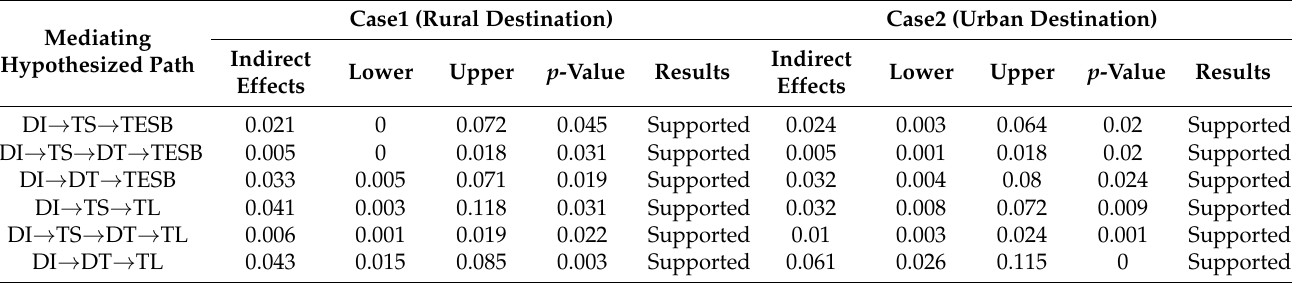
Table 5. Specific mediation test